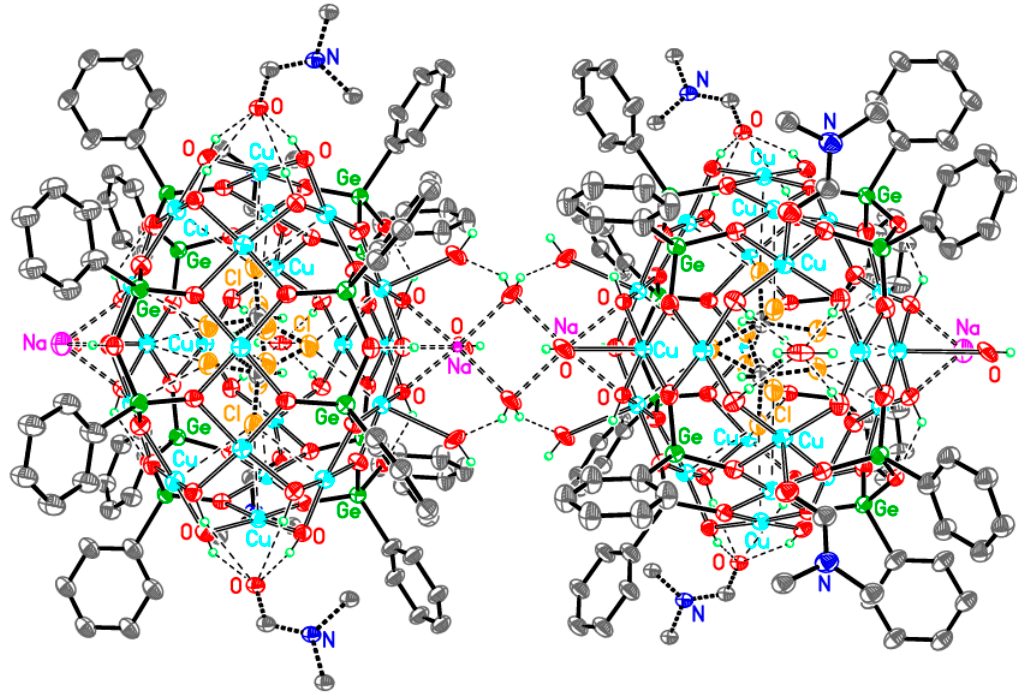
Figure 15. The copper complex with germsesquioxane surroundings. Adapted from Ref. [87], Copyright (2018), Catalysts, MDPI.